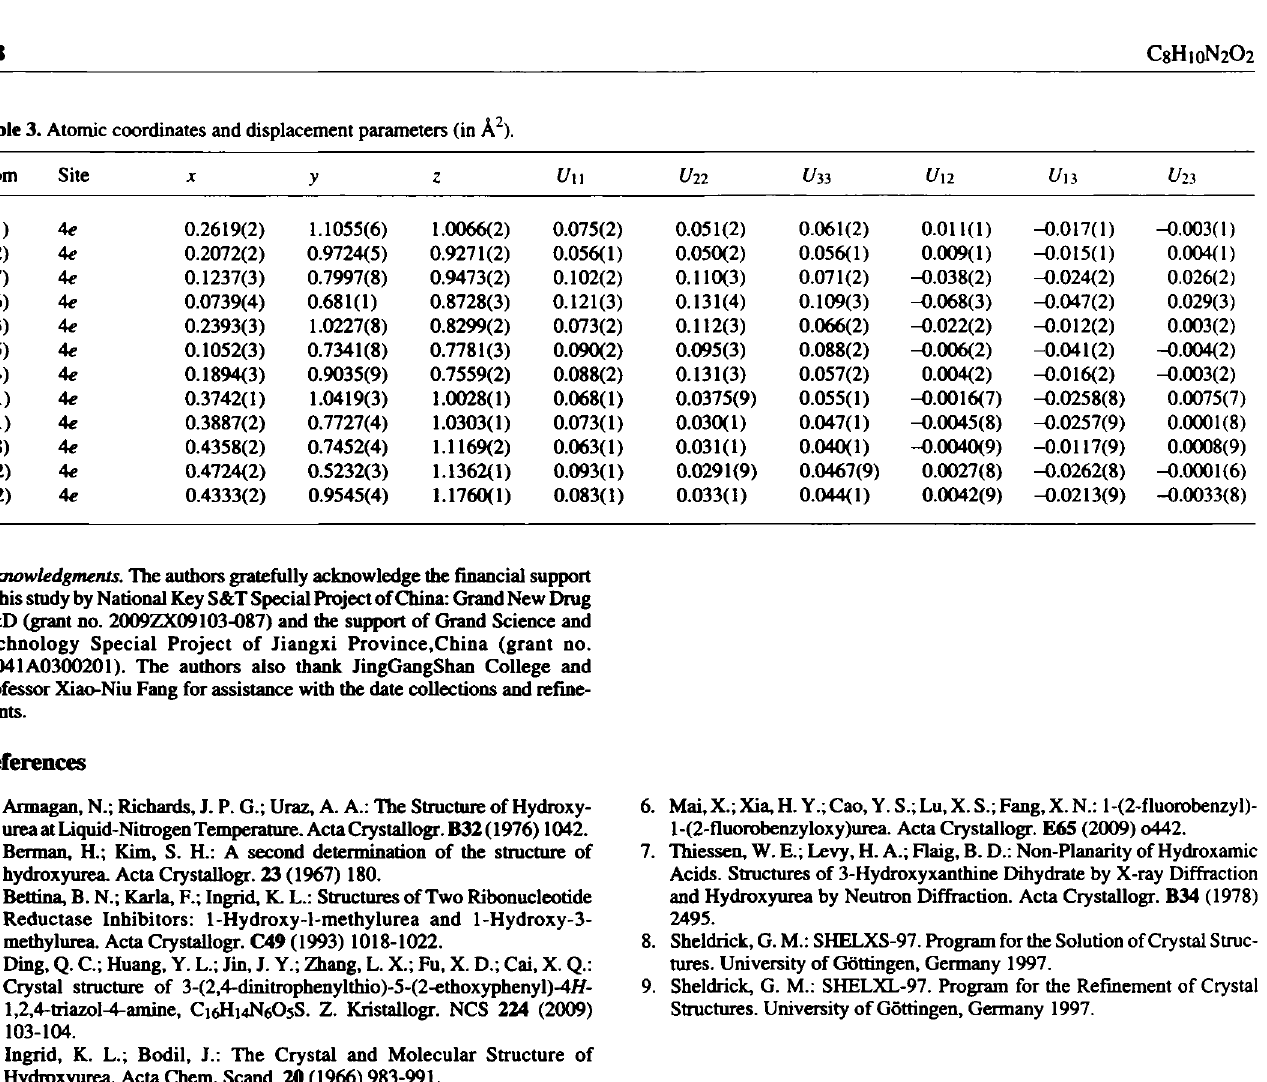
Table 3. Atomic coordinates and displacement parameters (in Â 2